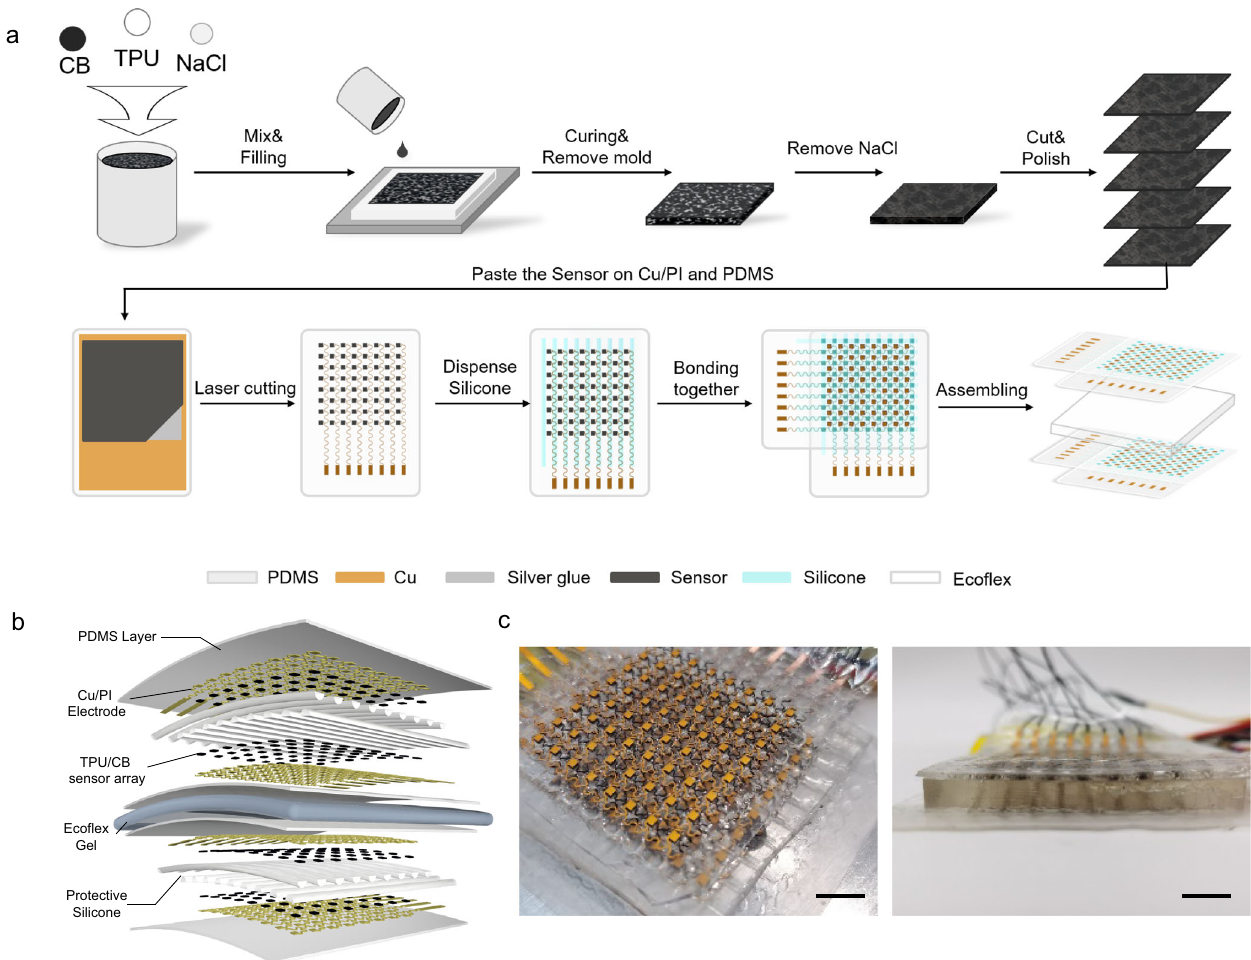
Fig. 2 Fabrication procedures of BMRs and the assembled device. a Schematic diagram of the fabrication procedures for BMRs. b Exploded view of the layered structure of BMRs. A deformation layer made of Eco fl ex gel is sandwiched between an ‘ epidermal ’ sensing array and a ‘ dermal ’ sensing array. Both ‘ epidermal ’ and ‘ dermal ’ sensing arrays contain fi ve functional layers, i.e., PDMS substrate, upper Cu/PI serpentine electrode, pressure sensor array, protective silicone, and lower Cu/PI serpentine electrode. c Optical images of a BMRs device. Scale bar: 1 cm ( c